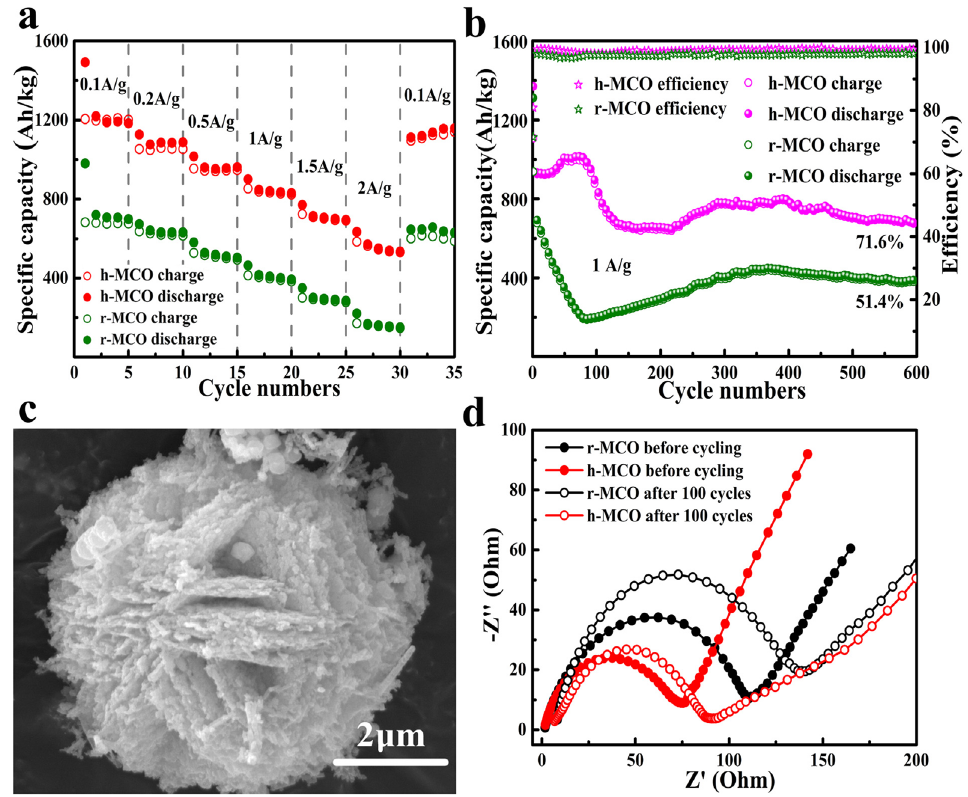
Figure 4. ( a ) Rate performances of the MCOs; ( b ) Long cycling performances of the MCOs at 1 A g − 1 ; ( c ) FE-SEM image of h-MCO after 5 cycles at 0.1 A g − 1 ; ( d ) Nyquist profiles of MCOs before cycling and after 100 cycles. Reproduced with permission from Xiaolan Song, Hydrothermal synthesis of porous hydrangea-like MnCo 2 O 4 as anode materials for high performance lithium-ion batteries; published by Elsevier, 2019 [58].